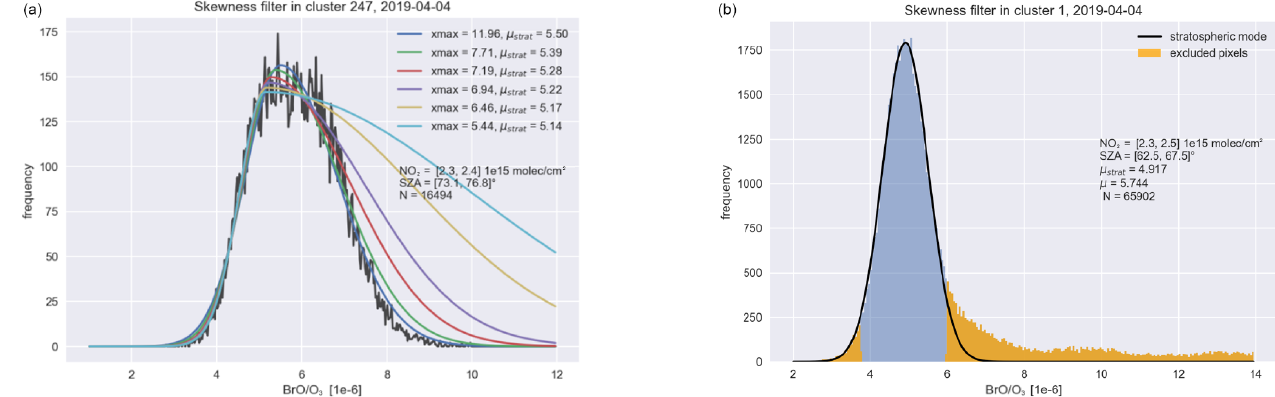
Figure A2. Different parameter choices for the stratospheric background calculation: visualized (a) , final parameter choice (b) .